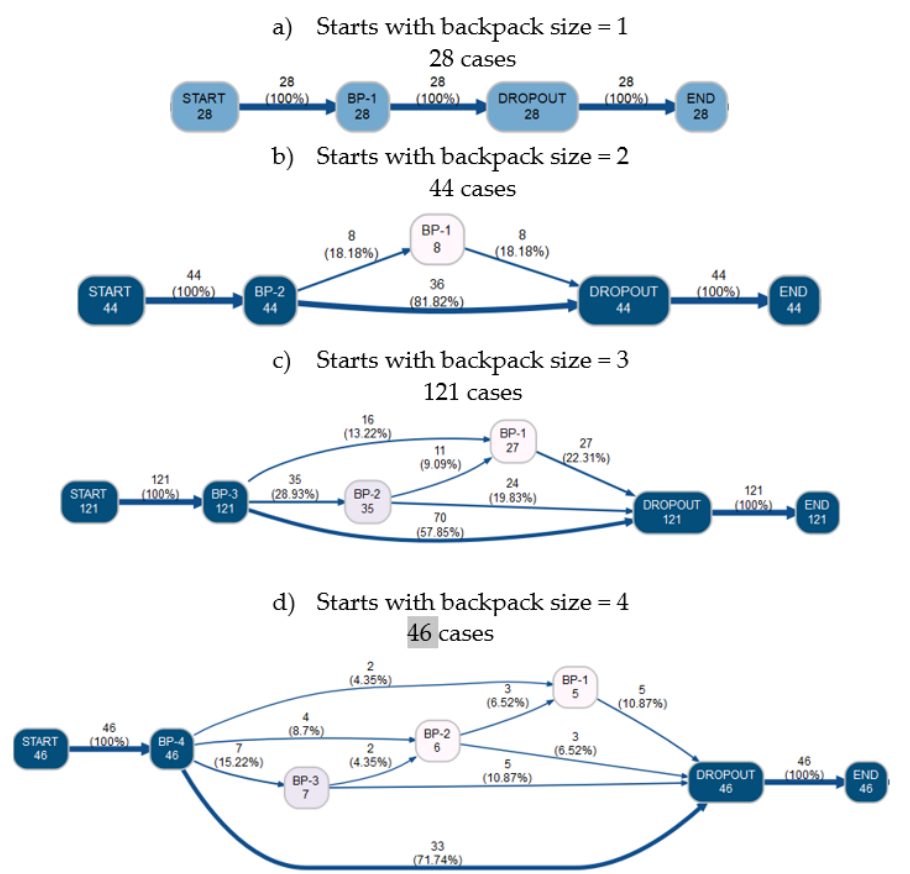
Figure 10. Educational trajectories that ended in DROPOUT, according to the BPPM-S model. ( a ) Shows only students who started with only one course in the backpack. ( b ) Shows only students who started with two courses in the backpack. ( c ) Shows only students who started with three courses in the backpack. ( d ) Shows only students who started with four courses in the backpack. The darker color of the nodes represents a higher percentage of students who went through a state. The thickness of the arrows represents the percentage of students who had transitions between both states. All values are percentages in relation to the total number of students included in each model.